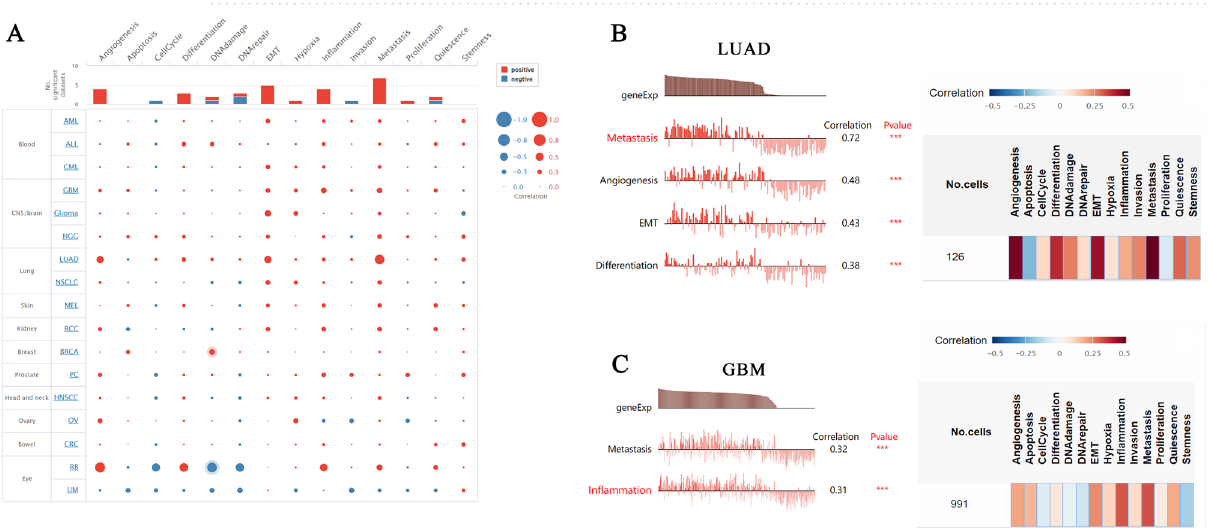
Figure 5. Correlation between CD44 expression and immune-related genes ( A ). Correlation between CD44 expression and immune checkpoint genes ( B ). * P < 0.05, ** P < 0.01, and *** P < 0.005.